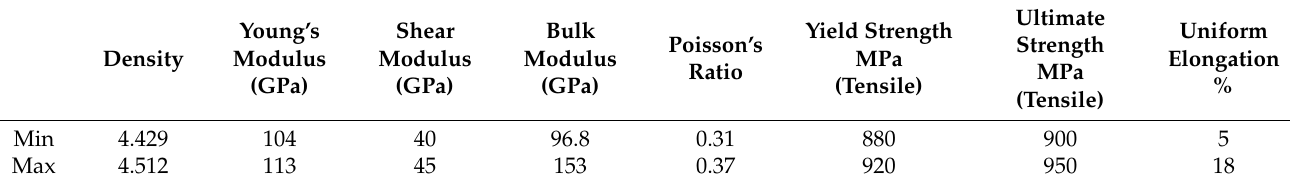
Table 3. Mechanical properties of prepared Ti-6Al-4V